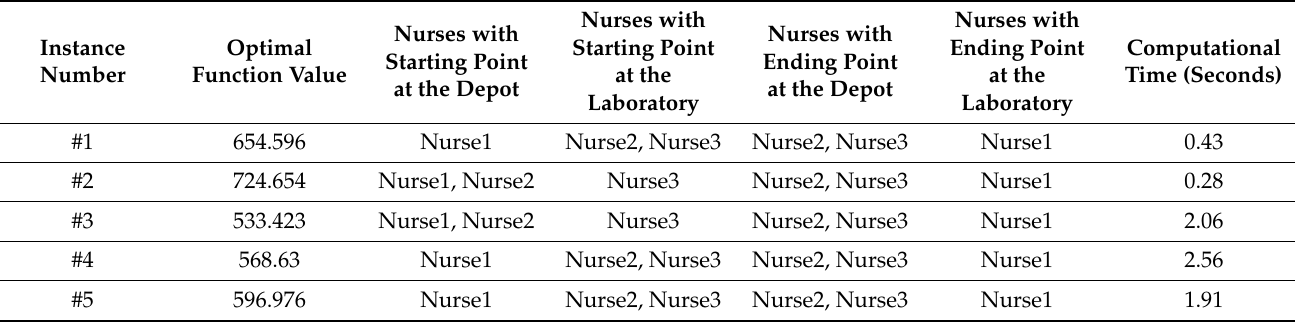
Table 5. The results for the small